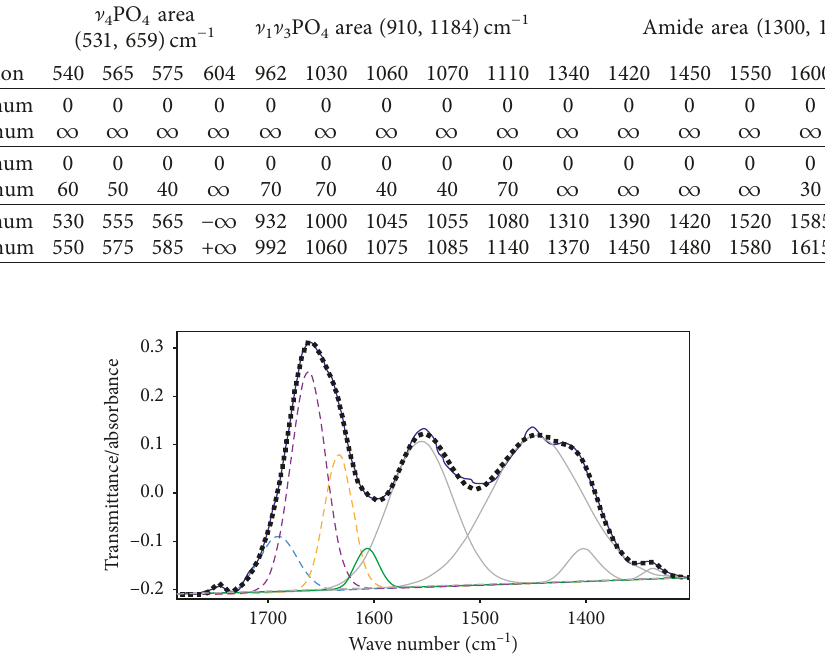
Figure 4: Graphical representation of the baseline creation. Red dotes are local minima, and the black line is the created Table 1: Boundaries of each peak used for the peak fitting method. The ] the amide area contains 8 peaks. Each peak’s parameter (height, FWHM, and position) is searched between the defined minimum and maximum boundaries, expressed in the table, by the fitting algorithm.